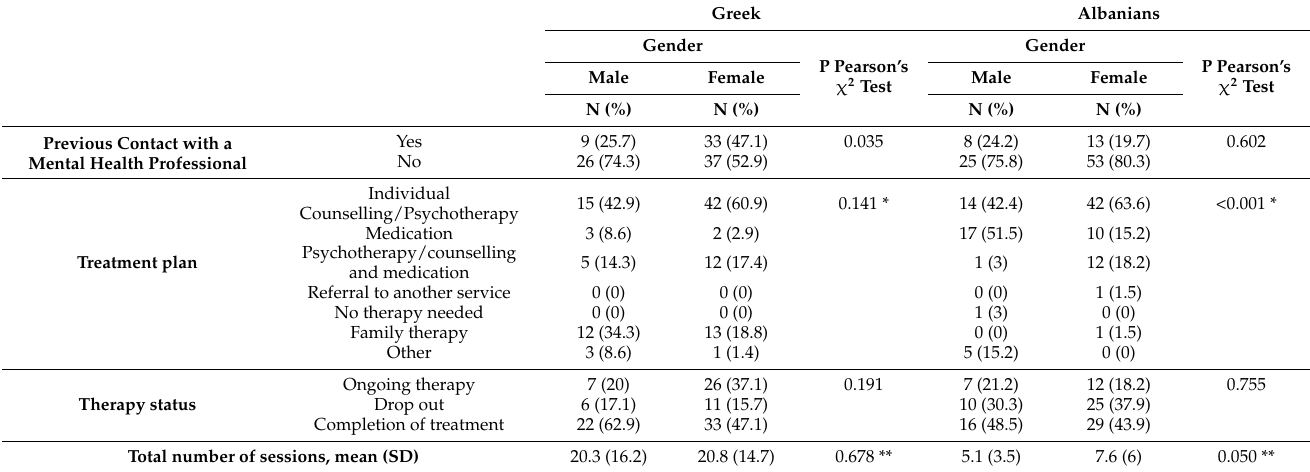
Table 6. Gender correlations with variables related to service contact, treatment plan and course of